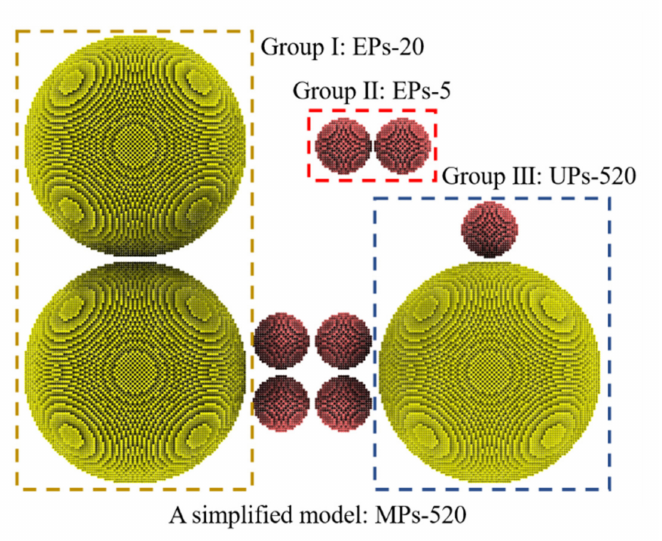
Figure 15. A simplified model MPs-520 was used to represent the composition of MPs, including three basic groups. Nanoparticles with diameters of 5 nm are colored red, and those with diameters of 20 nm are colored yellow.